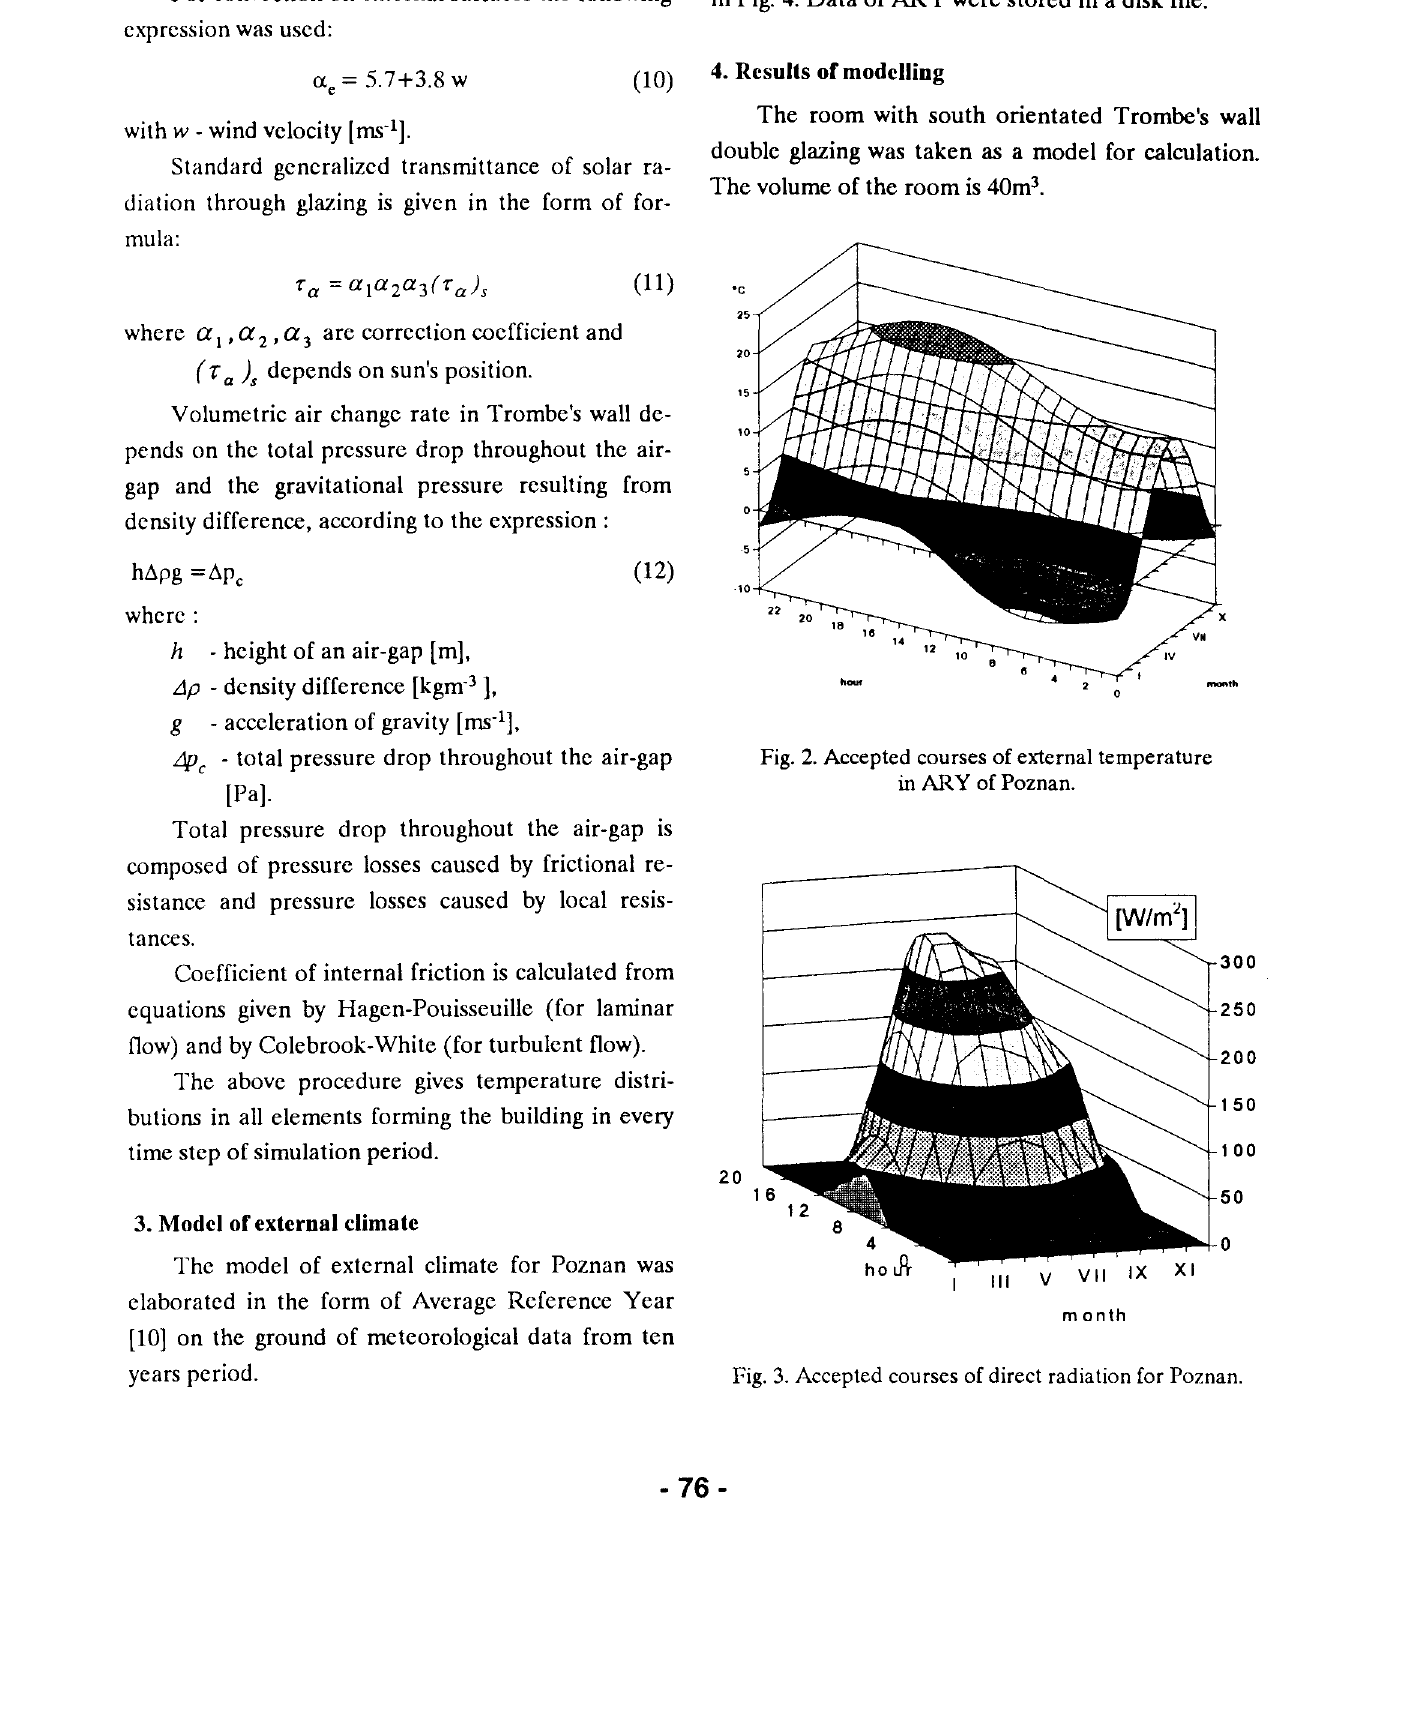
Fig. 2. Accepted courses of external temperature in AR Y of Poznan.